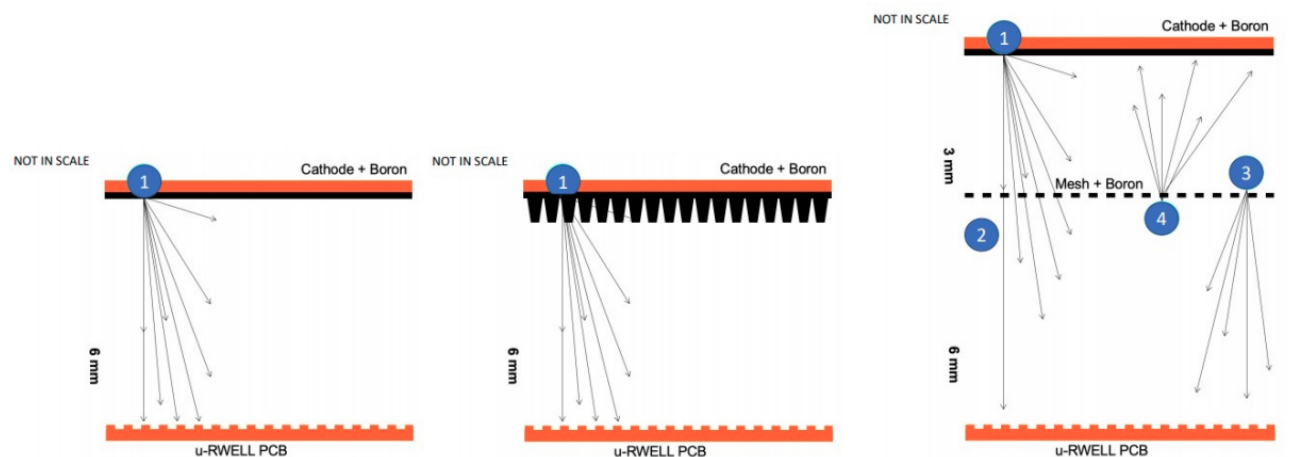
Fig. 1. Summary of the three detector designs under study in the URANIA-V project. From the left ot the right: planar cathode, grooved cathode and planar cathode with a mesh. Cathode and mesh are boron-coated. The numbers from 1 to 4 summarize the different processes.